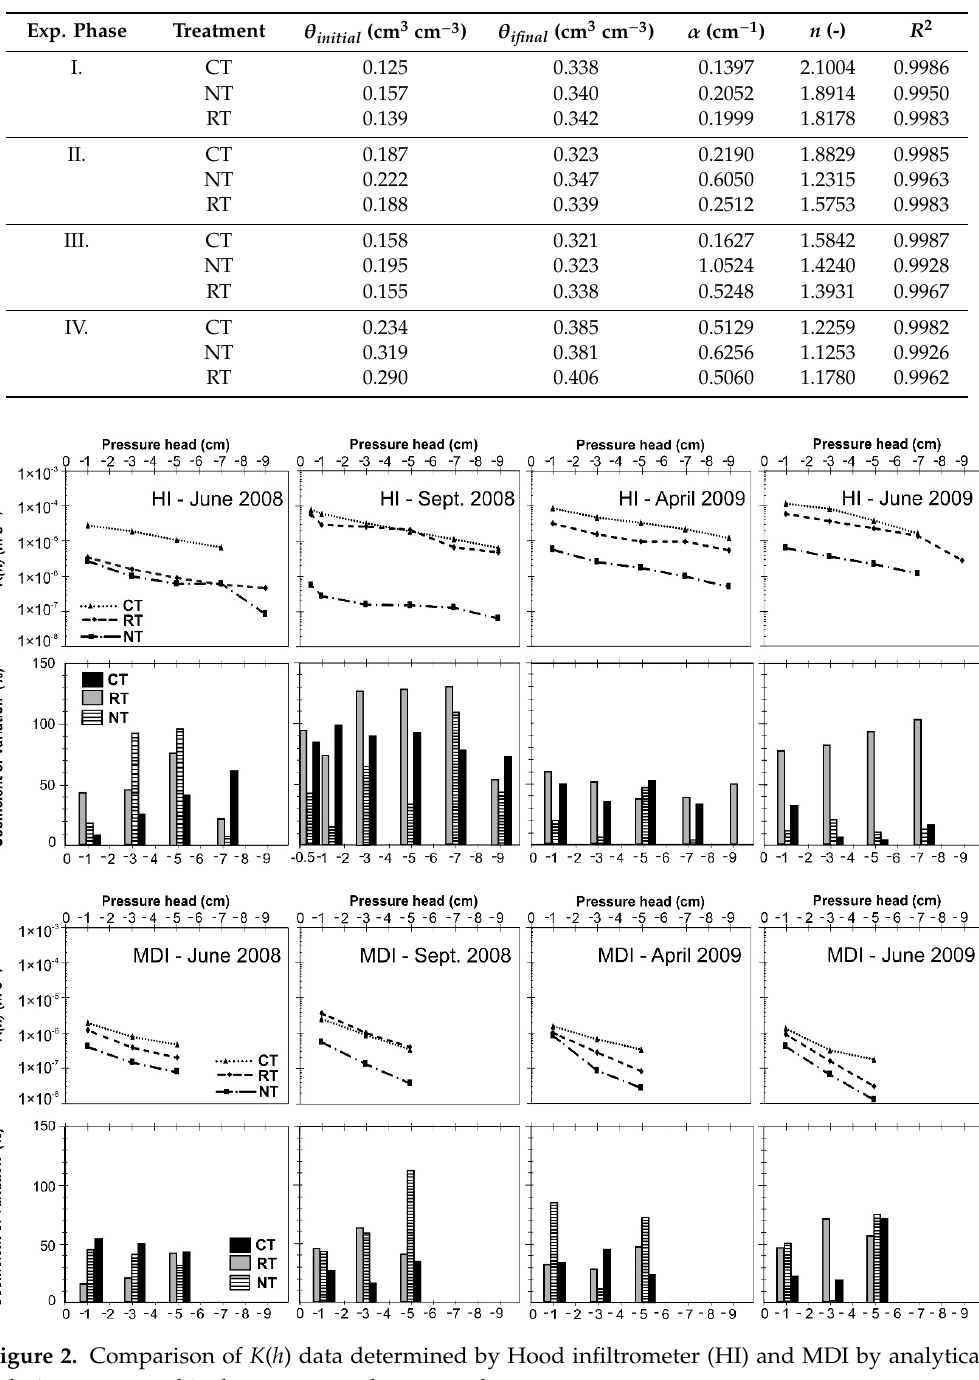
Table 3. Initial ( θ initial ) and final ( θ final ) soil moisture contents together with the resulting α and n parameters obtained by the HYDRUS 2D / 3D data analysis method applied on the MDI data; coe ffi cient of determination R 2 represents quality of the fit.